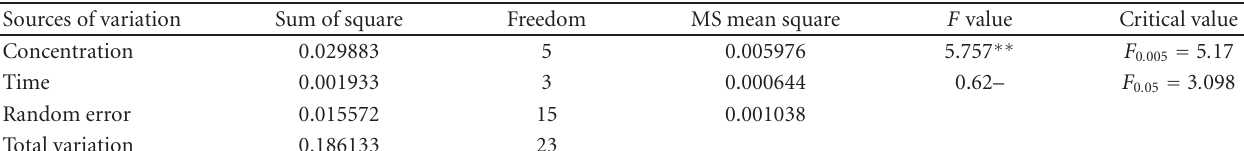
Table 3: Two dimension variance analysis of di ff erent time and concentration of colchicine treatments on C. roseus tetraploid plants pro- duction.